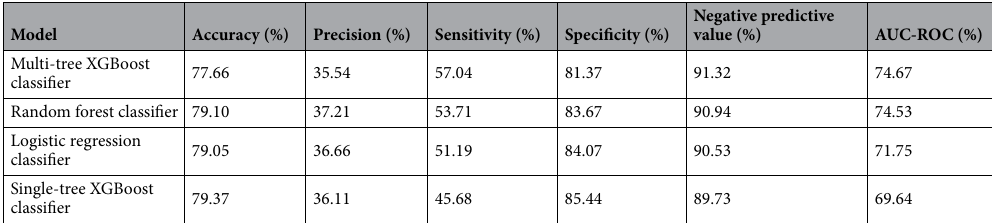
Table 1. Predictive performance of each COVID-19 diagnosis prediction model in the test